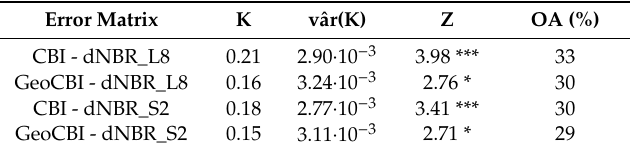
Table 1. Error matrix statistics for each combination of ground-based burn index (composite Burn Index (CBI) and geometrically modified CBI (GeoCBI)) and reflectance-based delta Normalized Burn Ratio (dNBR) index derived from Landsat-8 OLI (dNBR_L8) and Sentinel-2A MSI (dNBR_S2). K represents the unweighted kappa value and v â r(K) the corresponding variance, Z is the score of Z test statistics and OA indicates the overall accuracy. Each statistic was computed on the complete field dataset (n = 90 plots). See Table S1 for category and ranges of the ground-based burn severity index, and Key and Benson [10] for categories and ranges of the dNBR index. Significance p -values of Z scores are represented as *, **, and ***, which correspond respectively to p < 0.05, p < 0.01 and p < 0.001.